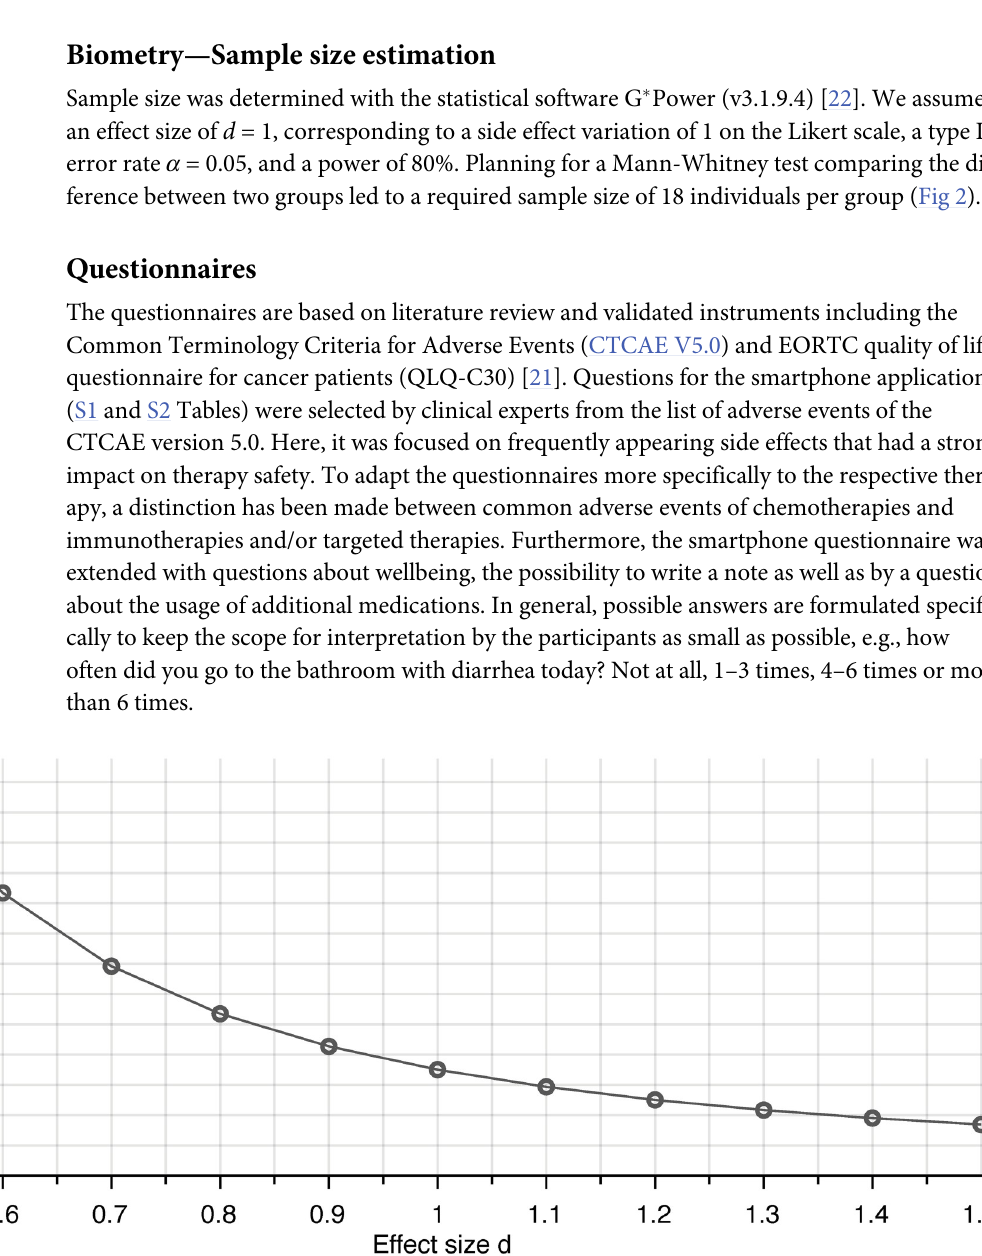
Fig 2. Sample size estimation. Sample size calculation for the Mann-Whitney test given an effect size of d = 1, a type I error rate α = 0.05, a power of 80% led to a required sample size of 36 participants, separated into two groups of 18 individuals each.